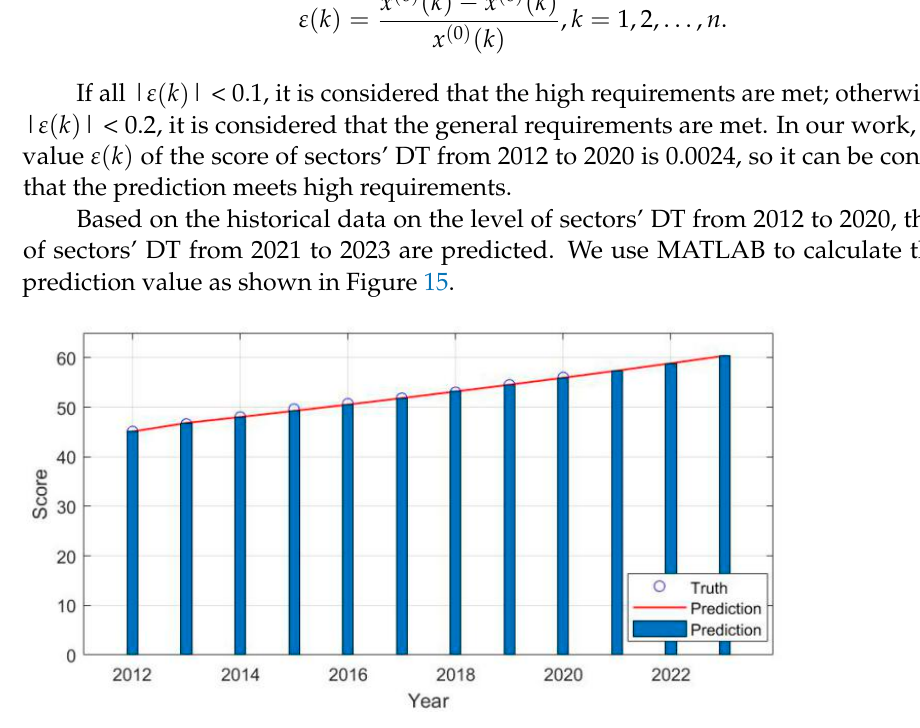
Figure 14. Historical data of sector’ digital transformation in China.